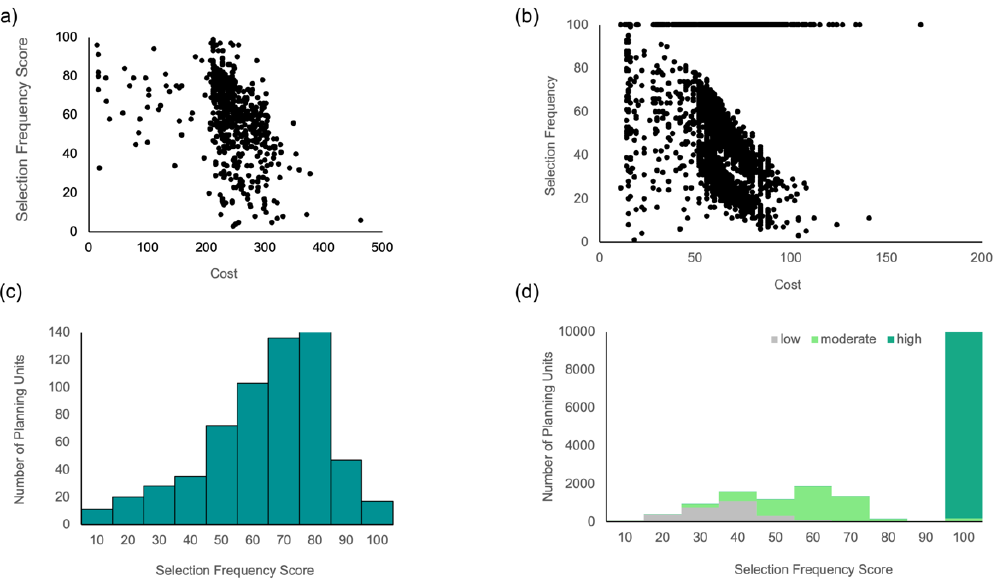
Figure 4. Distribution of planning units among different selection frequency scores for ( a ) tiger habitat and ( b ) biodiversity potential. Selection frequency versus the cost of planning units for ( c ) tiger habitat and ( d ) biodiversity potential.